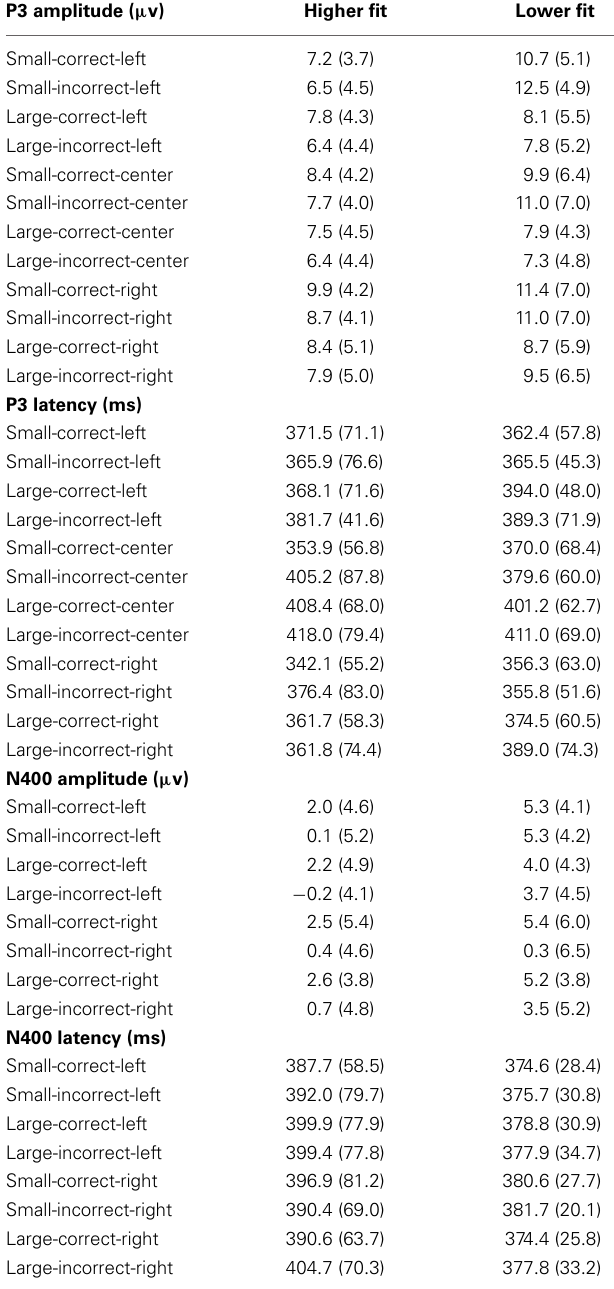
Table 3 | Amplitude and latency data for the P3 and N400 components for higher fit and lower fit